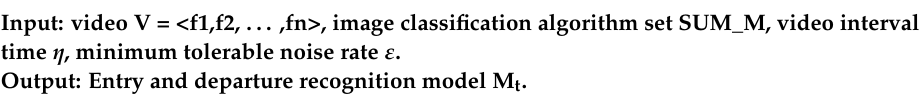
Algorithm 1 Entry and Departure Model Training